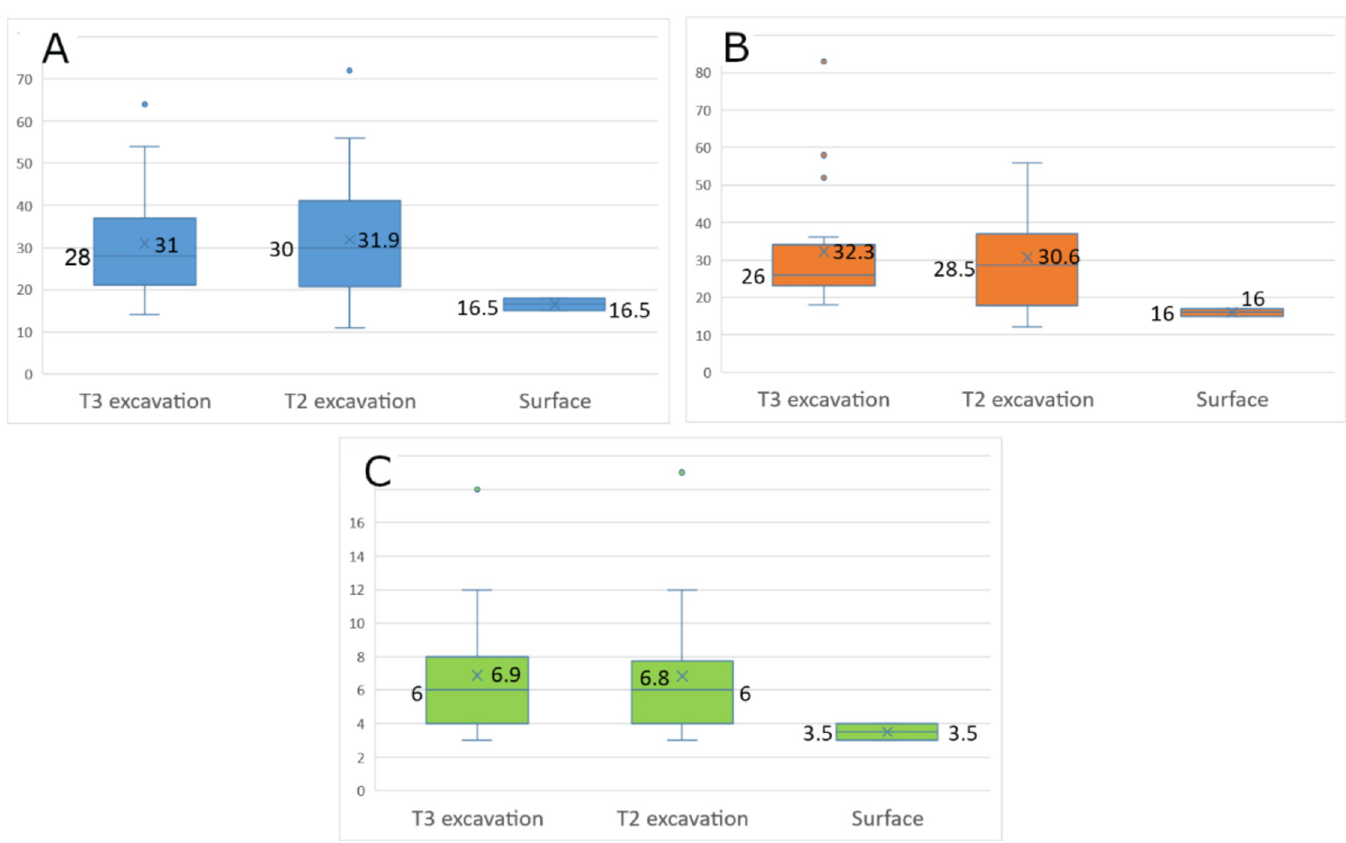
Fig 41. Length (A), width (B), and thickness (C) of limestone thinning flakes by assemblage (in mm). The ‘X’ sign represents the mean value of each group, the line within the rectangles represents the